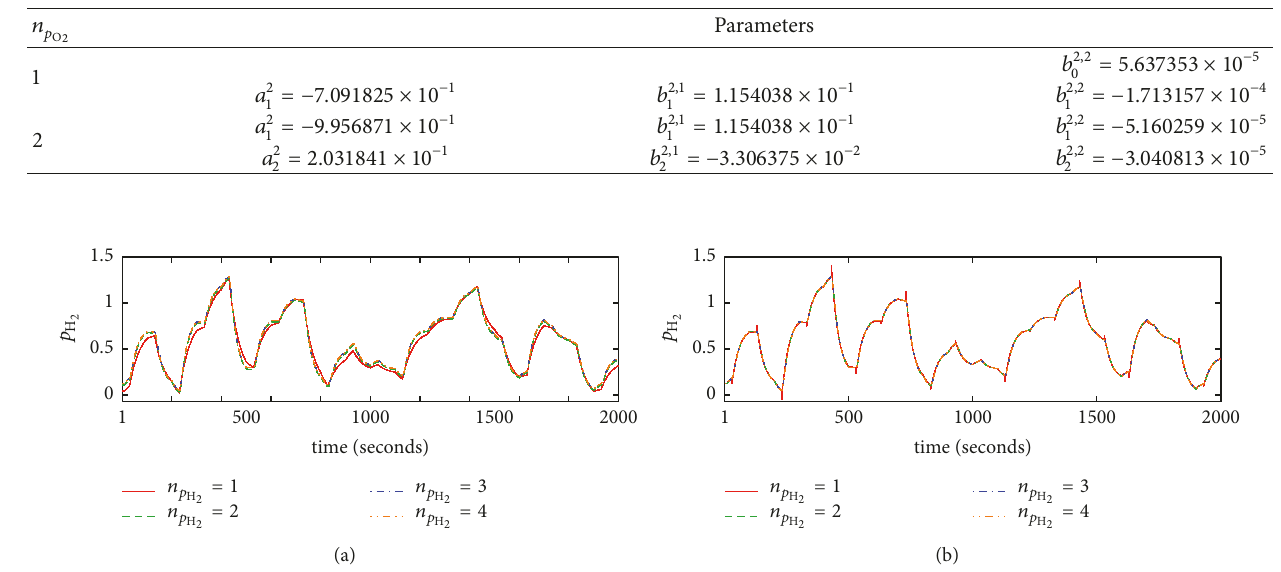
= 1, 2,3 ) and full order ( 𝑛 = 4 ) models determined by 𝑝 H 2 H 2